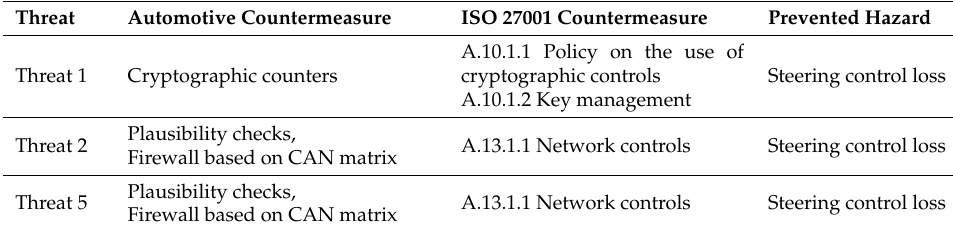
Table 16. Relations between Threats, Automotive Security Controls, ISO 27001 Controls, Attacker caused